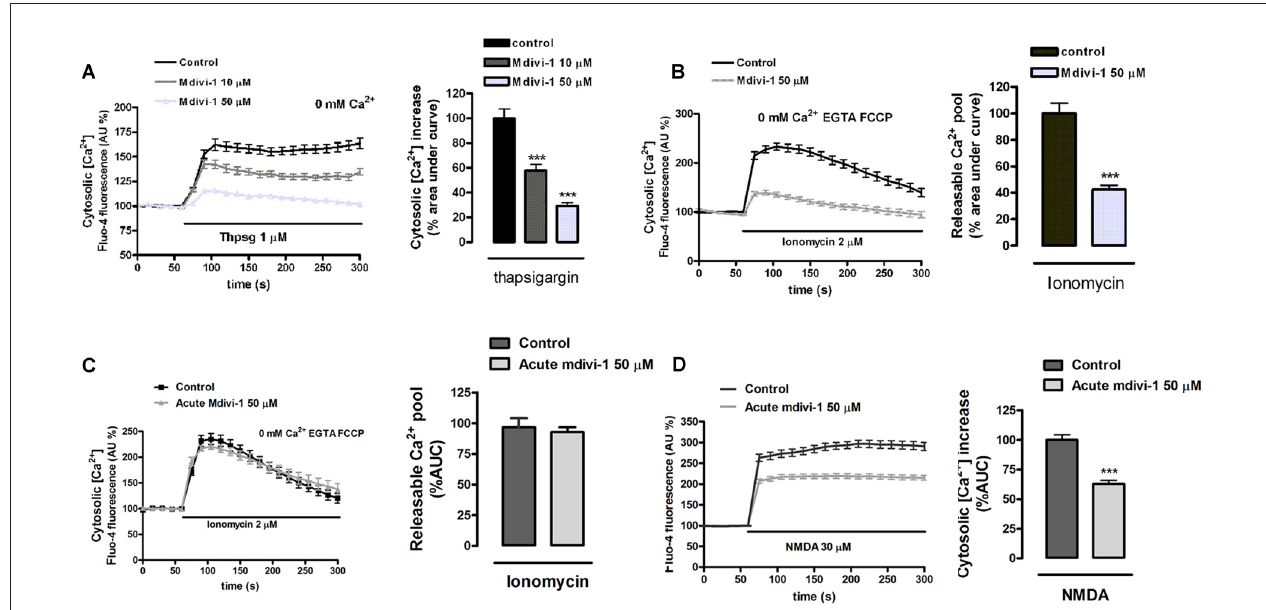
FIGURE 5 | Preincubation of neurons with mdivi-1 depletes ER Ca 2 + store. (A,B) Neurons were incubated with Fluo-4 in a Ca 2 + -free medium and exposed to (A) thapsigargin and (B) ionomycin (2 µ M) plus FCCP (2 µ M) in the presence or absence of mdivi-1 (50 µ M). Resulting cytosolic Ca 2 + increase was measured to determine ER Ca 2 + content. (C) Ionomycin (2 µ M) plus FCCP (2 µ M) was added in the presence ( n = 60 cells) or absence ( n = 59 cells) of acute mdivi-1 (50 µ M, 5 min). Resulting cytosolic Ca 2 + increase was measured to determine ER Ca 2 + content. (D) Fluo-4-loaded neurons were exposed to NMDA (30 µ M) as indicated in the absence ( n = 83) or presence ( n = 90) of mdivi-1 (50 µ M, 5 min) and cytosolic Ca 2 + load quantified. Traces represent normalized means ± SEM of cells from at least three independent cultures/experiments. ∗∗∗ p < 0.001 compared to control cells (thapsigargin, ionomycin or NMDA alone), Mann-Whitney U